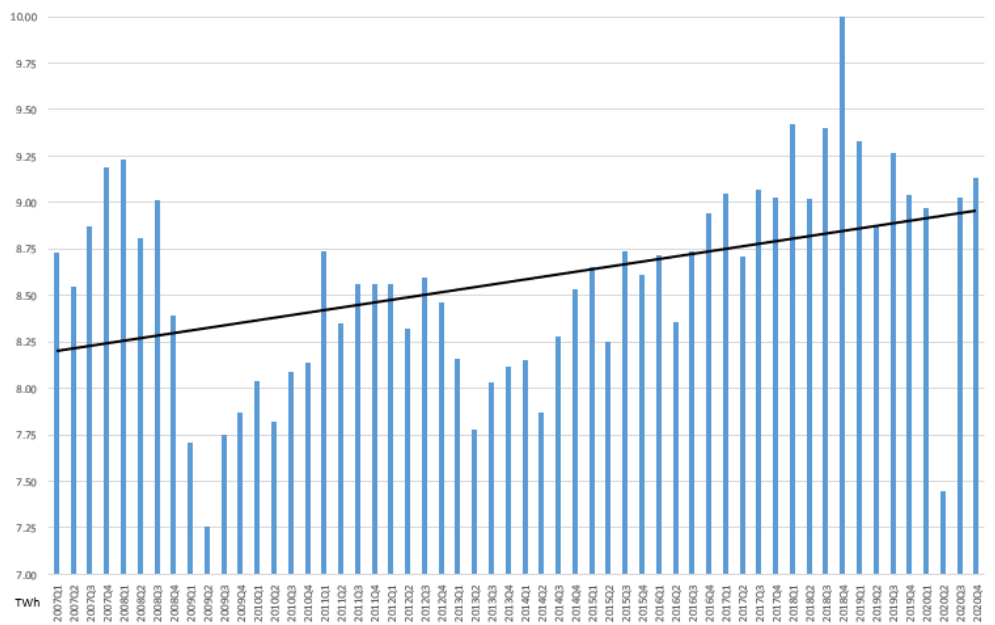
Figure 5. The evolution of non-household electricity consumption during the period 2007–2020.